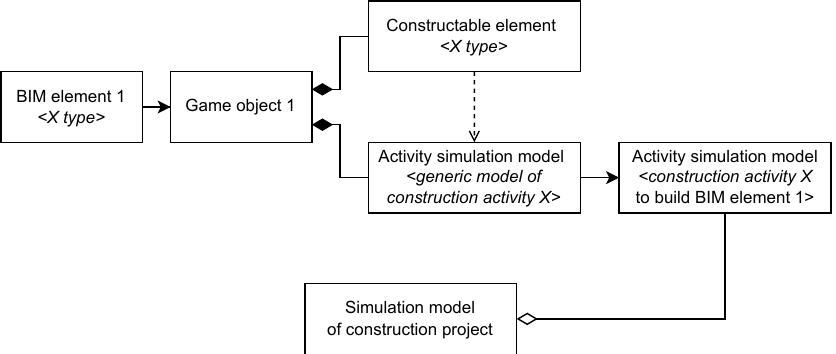
Figure 8. Federating a construction activity submodel into the simulation model of the